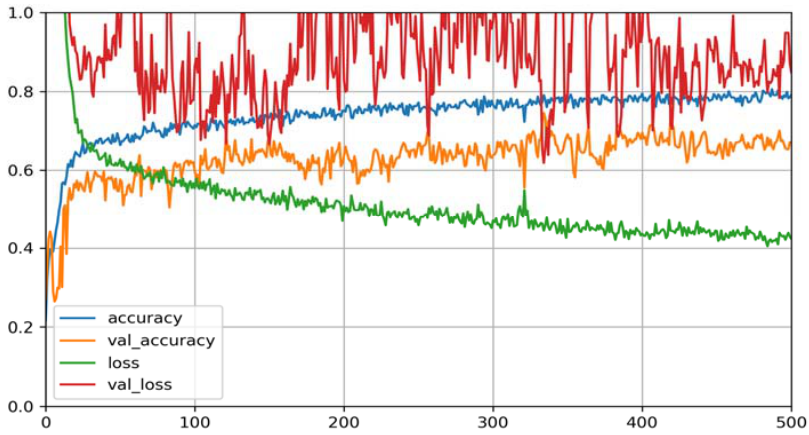
Figure 18. Raw data training and testing accuracy and loss functions.